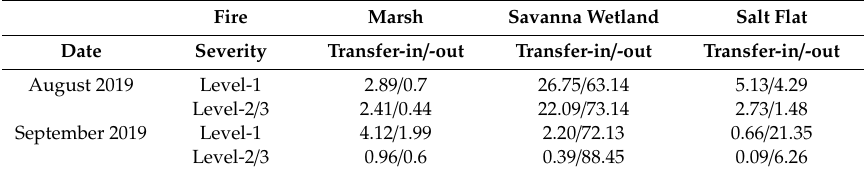
Table 4. Fire severity and conversion of wetland types. Unit: %.